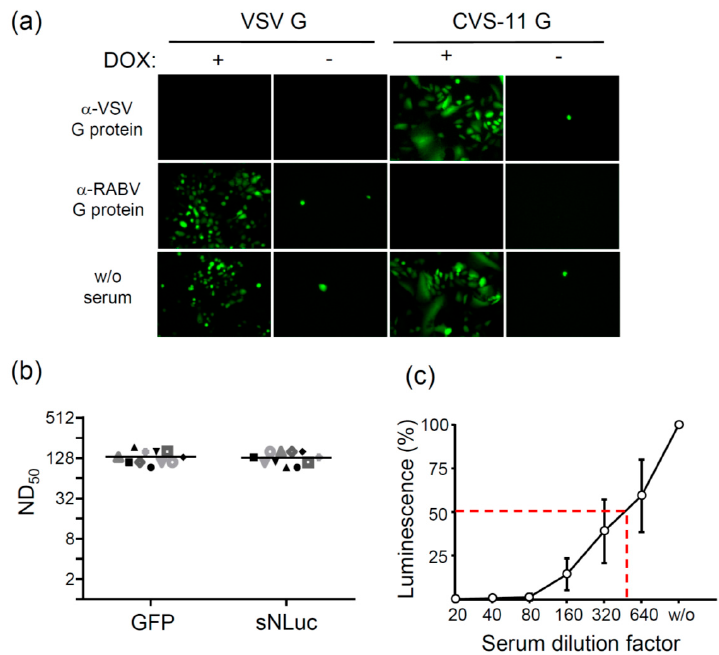
Figure 3. Pseudotype virus neutralization (PVN) test using the GFP reporter for detection. VSV* ∆ G(FLuc) was trans -complemented with G protein from either VSV or CVS-11. ( a ) The trans -complemented viruses (100 f.f.u.) were incubated for 60 min with either anti-RABV reference serum (2 IU/mL, 1:80), anti-VSV serum (1:100) or without (w/o) any serum and subsequently inoculated with either T-Rex™-CHO-SAD-G helper cells (if virus was trans -complemented with VSV G protein) or T-Rex™-CHO-VSV-G helper cells (if virus was trans -complemented with CVS-11 G protein) in the presence or absence of DOX. Expression of GFP was visualized 24 h post inoculation by fluorescence microscopy; ( b ) Comparison of the GFP and luciferase reporter read-outs. Serial two-fold dilutions of human anti-RABV reference serum (2 IU/mL) were incubated in quadruplicates for 60 min with 100 focus-forming units (f.f.u.) of VSV* ∆ G(sNLuc) that was trans -complemented with the CVS-11 G protein. Vero cells were added to the wells and incubated at 37 ◦ C for 20 h. GFP expression was monitored by fluorescence microscopy. In parallel, the secreted Nano luciferase (sNLuc) activity was determined in the cell culture supernatant. The luciferase endpoint titers were calculated according to the method by Spearman–Kärber using a cutoff value of 200 RLU (see Figure 2e). The mean values of 11 independent experiments are shown; ( c ) The luciferase data were also used to calculate the serum dilution causing a reduction of luciferase by 50% (red dashed line). The luminescence recorded following infection of the cells in the absence of antibody was set to 100%. Mean values ( n = 11) and standard deviations are